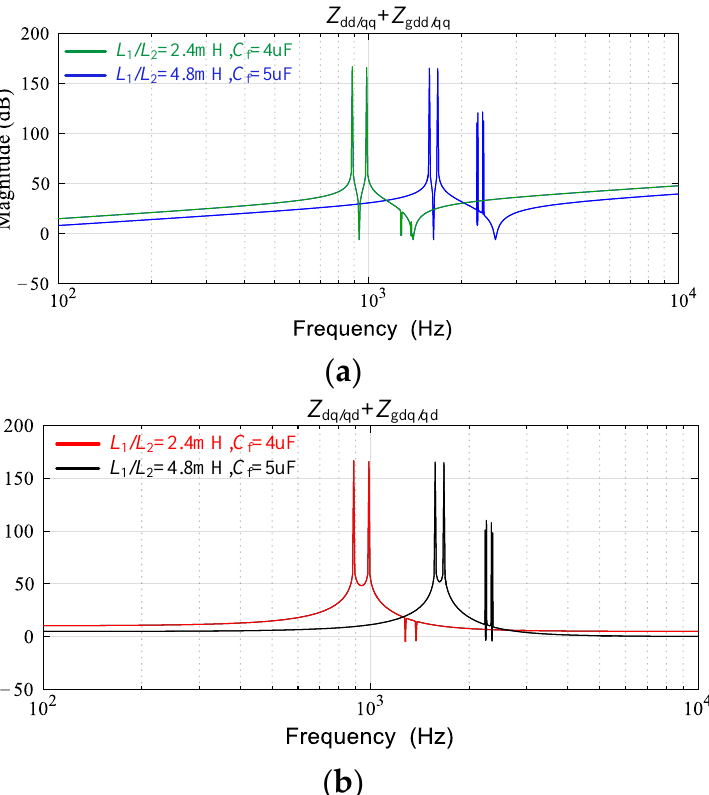
Figure 7. Impedance Bode plots under different parameters of a filter without an inner regulator. ( a ) Impedance characteristics on the main diagonal. ( b ) Impedance characteristics on the subdiago- nal.